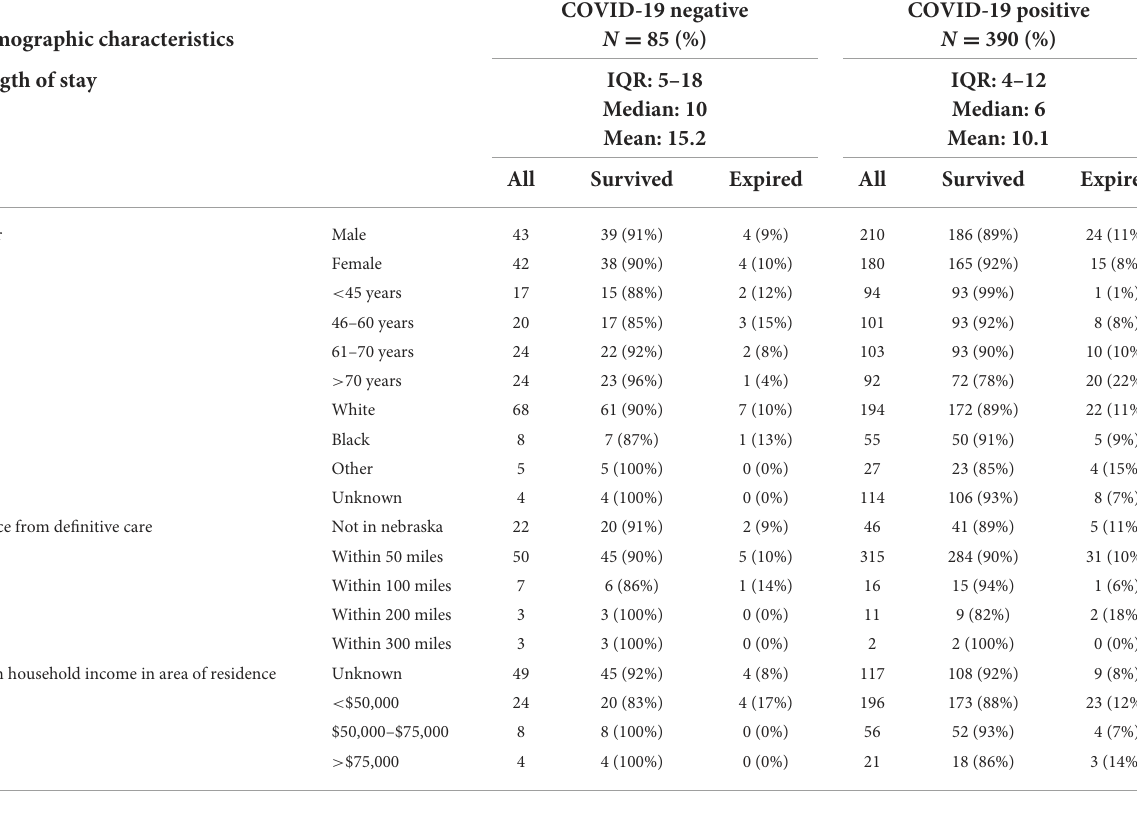
TABLE 1 Demographic characteristics by COVID-19 status among patients at Nebraska Medicine between April and October 2020, Omaha, Nebraska.